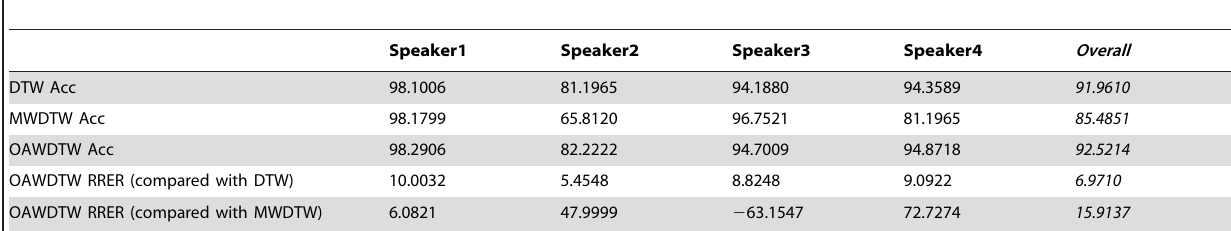
Table 6. DTW accuracy (DTW Acc) and OAWDTW accuracy (OAWDTWAcc)(%) comparison, and OAWDTW relative reduction of error rate (OAWDTW RRER) (%) based on